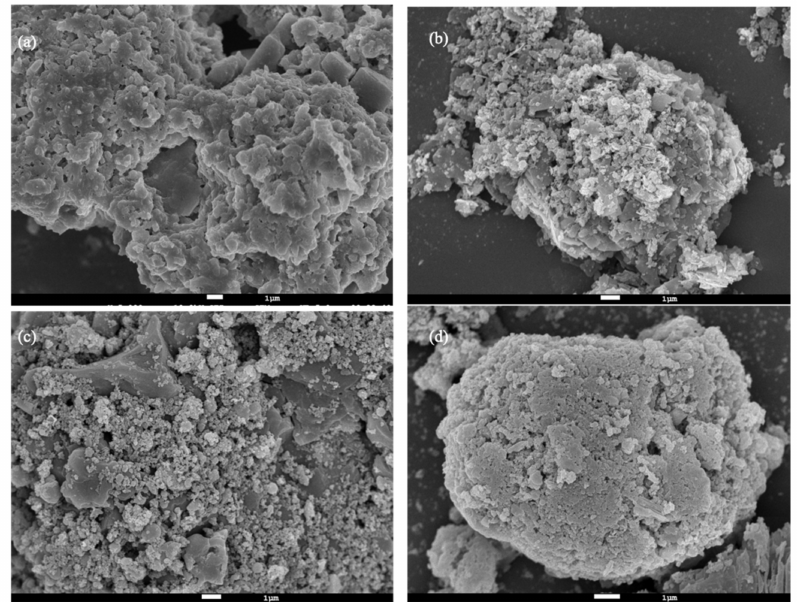
Figure 5. SEM image of raw fly ash ( a ), UAW by citric acid treated fly ash ( b ), UAW by ascorbic acid treated fly ash ( c ), and UAW by EDTA-Na 2 treated fly ash ( d